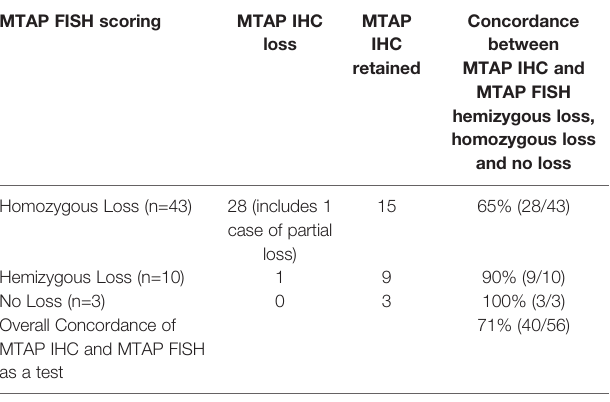
TABLE 9D | Comparison of methylthioadenosine phosphorylase (MTAP) immunohistochemistry (IHC) and CDKN2A droplet digital PCR (ddPCR) homozygous and hemizygous deletion, and no loss